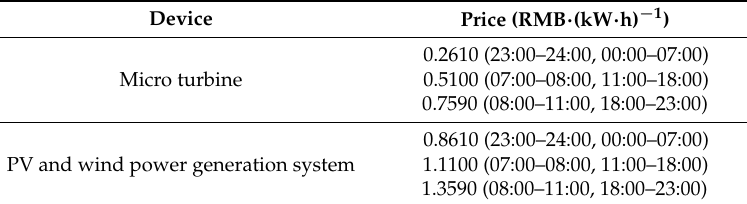
Table 4. Electricity selling price of the PV, wind and micro-turbine power generation